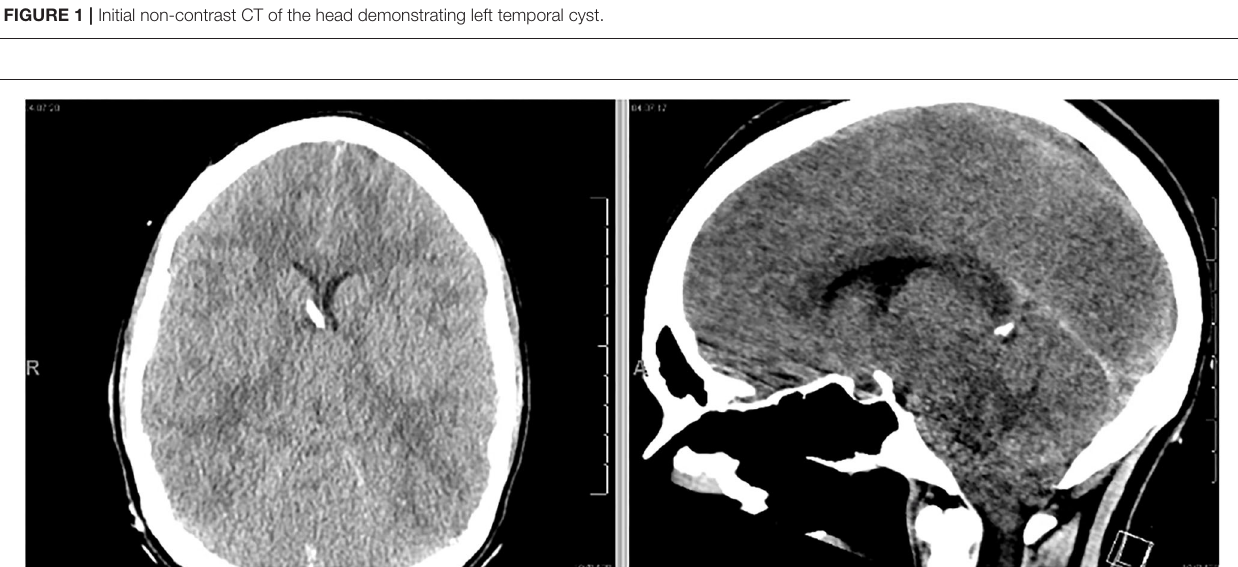
FIGURE 1 | Initial non-contrast CT of the head demonstrating left temporal cyst.